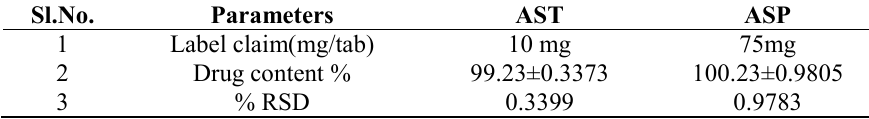
Table 8. Analysis of tablet